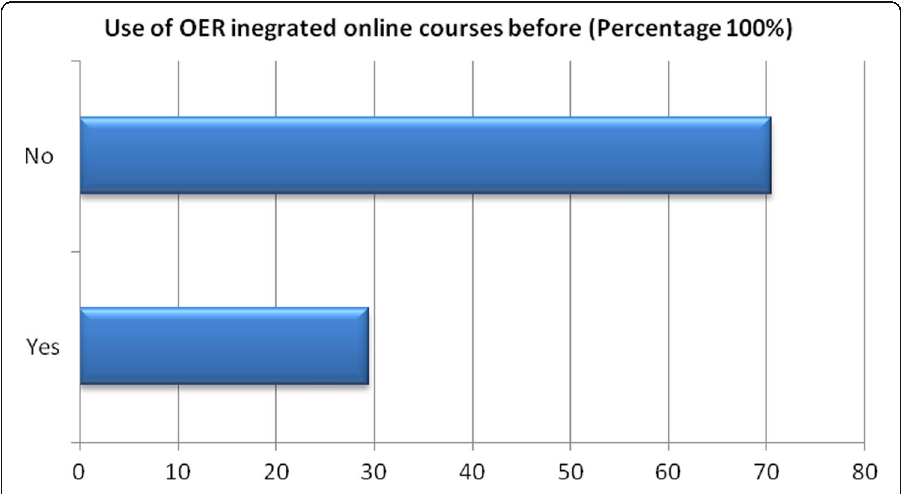
Fig. 2 Usage of OER integrated online